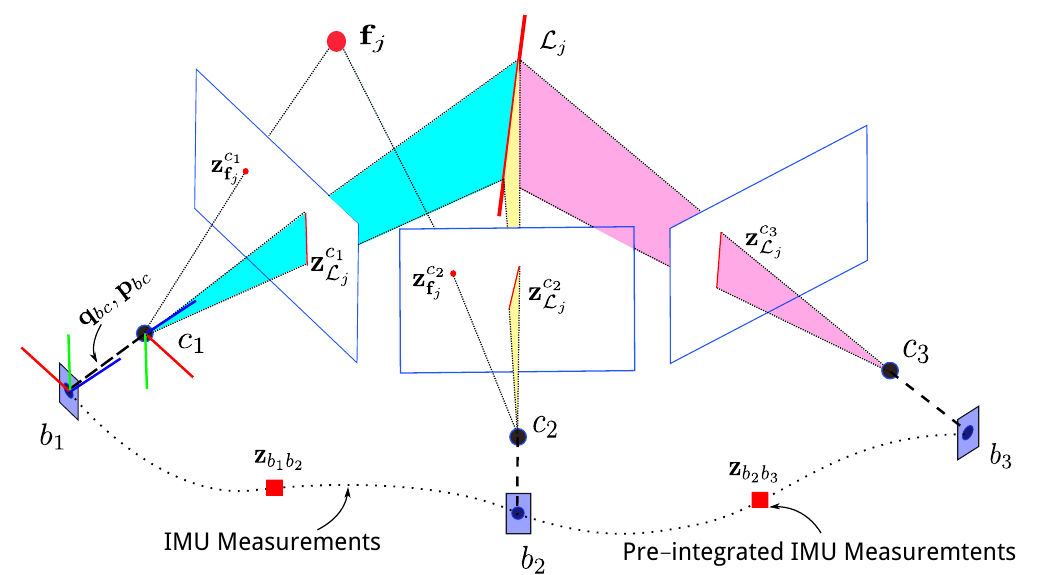
Figure 1. An illustration of visual–inertial sensors, point observations, and line observations. IMU: inertial measurement